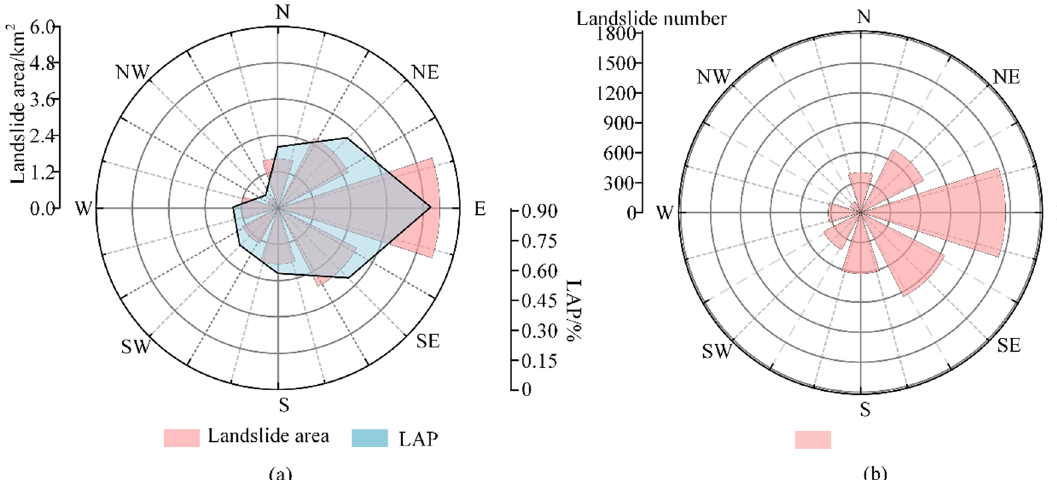
Fig. 10 Analysis diagram for landslide evaluation index and aspect of slope